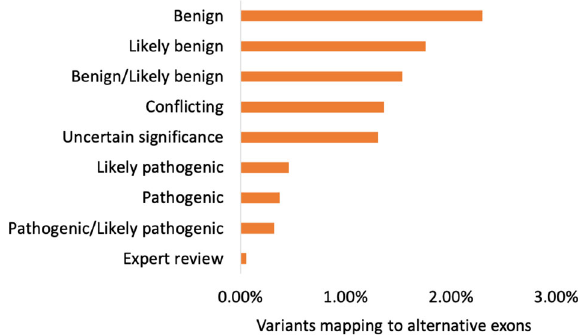
Fig. 2 The percentage of ClinVar variants that map exclusively to alternative exons. The small percentage of variants that do not map to APPRIS principal exons. Variants are grouped by ClinVar labels; the labels correspond to the CLIN_SIG entry. “ Expert review ” are variants labelled as “ reviewed by expert panel ” . Alternative exons make up 2.43% of all coding nucleotides, but <0.5% of all variants labelled with the word “ pathogenic ” fall in alternative